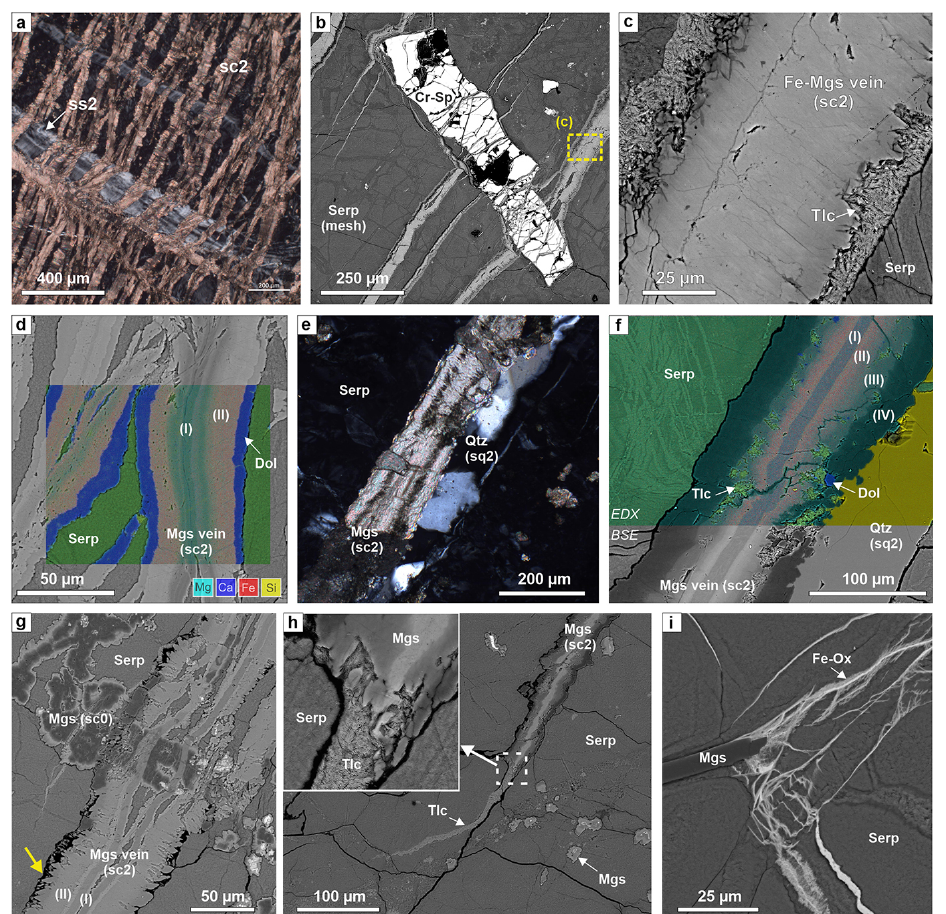
Figure 4. Microstructures of zoned magnesite veins (sc2) in serpentinite. (a) Close spacing of carbonate; the veins are deflected where they cut a crack–seal serpentine vein (xpol). (b) Elongated Cr spinel and serpentine mesh cut by zoned, Fe-magnesite–talc veins (BSE image). (c) Detail of (b) , showing talc seams along vein walls. (d) Composite-color EDX map superposed on a BSE image of zoned sc2 veins with dolomite rims (I: Ca-bearing magnesite; II: Fe magnesite); for phase legend see Fig. 3c. (e) Quartz vein exploiting the vein–host interface of a zoned magnesite vein (xpol). (f) Composite-color EDS map superposed on a BSE image of a part of the vein in (e) , with zones of (I) Ca- bearing magnesite, (II) Fe magnesite, (III) Fe-bearing magnesite with talc inclusions, and (IV) Fe-poor magnesite. Small Mg / Si variations show thin serpentine veins in the matrix. (g) Complex cross-cutting relations between a zoned sc2 vein and earlier mesh–pseudomorphic magnesite (sc0), showing that the core of sc2 veins formed by opening, while the vein rims are micro-reaction fronts with euhedral crystal terminations at the vein walls (yellow arrow). (h) Tip of a zoned sc2 carbonate vein in serpentinite. At the termination of magnesite, a talc veinlet continues over a short distance. This talc veinlet does not correspond to the open microcracks in serpentinite (black lines), showing that those are later and not related to vein formation of the zoned magnesite vein. (i) Fe-oxide and/or Fe-hydroxide veinlets emanating from the magnesite vein tip. ( a, d, g : BT1B_44-2_47-50; b, c, e, g, h : BT1B_44-3_9-11; i :